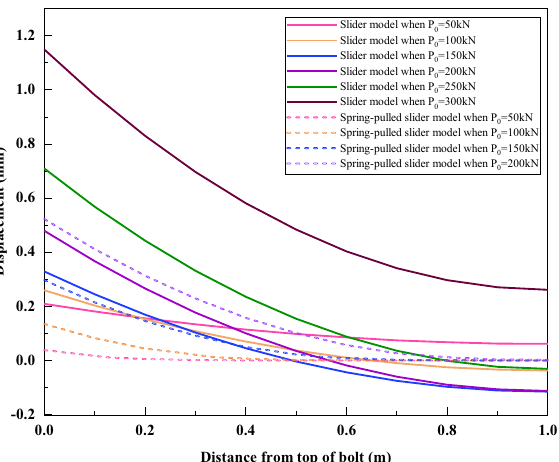
Figure 18. Comparison of displacement distribution curves of slider model and spring-pulled slider model.